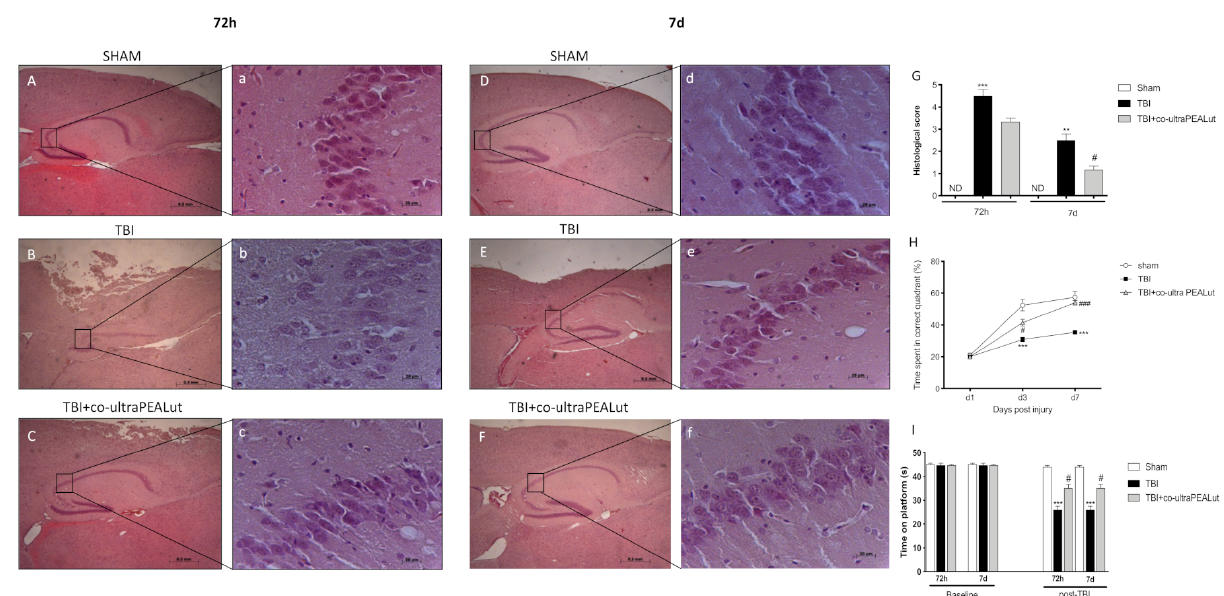
Figure 1. Effect of co-ultra PEALut on hippocampal morphology and spatial learning 72 h and 7 d after TBI. As compared with sham groups at 72 h and 7 d ( A , D , respectively, see histological score G ), TBI induced a significant alteration of tissue morphology ( B , E , respectively, see histological score G ) in the DG and CA3 region. Co-ultra PEALut treatment restored markedly hippocampal tissue. Scale bar = 0.5 mm ( A – F ) and 20 µ m ( a – f ) for higher magnification. One-way ANOVA test. # p < 0.05 vs. corresponding TBI. ** p < 0.01 vs. corresponding sham group. *** p < 0.001 vs. corresponding sham group (F 72h = 147.3 and F 7d = 42.25). TBI significantly impaired spatial learning at 72 h and 7 d compared to sham controls. Co-ultra PEALut improves spatial learning performance ( H ). *** p < 0.05 vs. Saline group. # p < 0.05 vs. TBI (F = 067). At 72 h and 7 d after TBI, animals showed significant impairments in motor deficits assayed by rotarod test. Co-ultra PEALut post-TBI significantly improved motor function evaluated by the rotarod task ( I ). One-way ( G , I ) and Two-way (H) ANOVA test. Data are expressed as Mean ± SEM from N = 10 mice for each group. *** p < 0.001 vs. Sham group; # p < 0.05 vs. TBI; ### p < 0.001 vs.